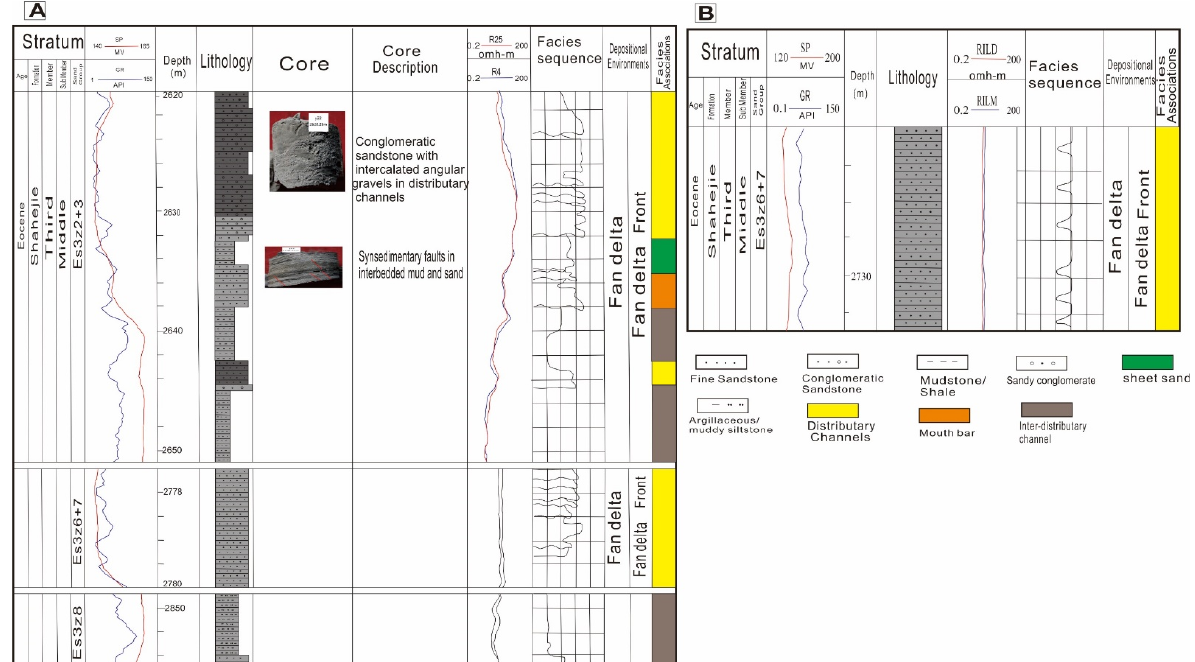
Figure 6. Core wells Y22 ( A ) and y23 ( B ) in the study area, which shows trend of log suits with lithology, core and indication of sedimentary facies. Cores of those dispatched in (Table 1). To describe the characteristics of the delta front, box shaped sandstone along with dominant parallel and minor cross bedding in coarse grained sandstone (PBCs) are found at the depth of 2041.85 m in well k47. (Figure 5B). Plant leaf is also seen, which shows its presence near to sources (Figure 5B). As delta prograde it forms a shallowing up pattern that contains younger sediments deposited in shallow water with overlying coarser sedi- ments (Figure 5B). In the wet tropical climate vegetation that covered the delta top or delta front, and over the bank, flood transports the beds further into inner part of the delta, which preserved the relics of vegetation in the form of roots or plant leaf (5B). Beside sandstone, Greenish gray mudstone (GGM) is interpreted to lie in inter-distributary chan- nels with higher GR values with erosion at the basal side and sharp contact with the sand- stone on the top, and it does not display any sedimentary structure due to less wave action and the fact that their deposition is near to sources (Figure 6B). Conversely, dark grey mudstone (DGM) with calcareous content is interpreted as inter-distributary mud in the outer delta front of lacustrine origin (Figure 5C). During transgression, mudstones are overlying on coarse grained beds of channel deposits. For lacustrine mudstone, GR log shows a constant sinusoidal curve, and SP log has higher values in well l-9 with no obvi- ous sedimentary structure.